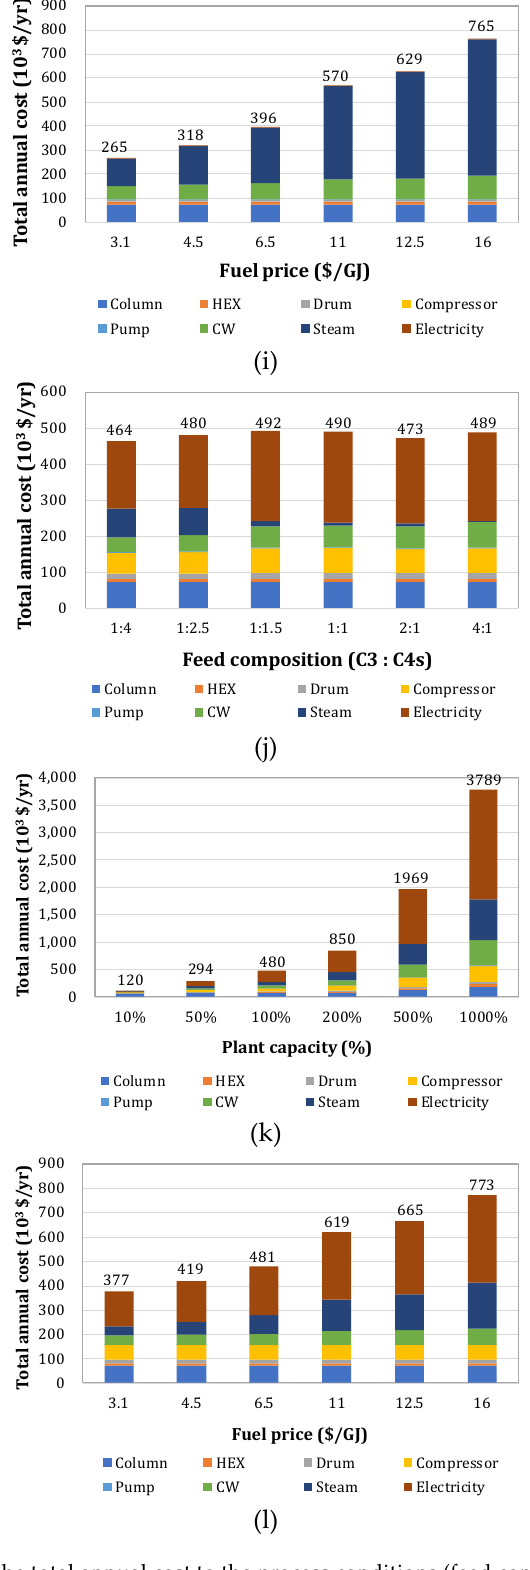
Figure 4. Sensitivity of the total annual cost to the process conditions (feed composition, plant capacity, and fuel price): ( a ), ( b ), and ( c ) Conventional C4 splitter; ( d ), ( e ), and ( f ) heat pump-assisted C4 splitter; ( g ), ( h ), and ( i ) conventional de-propanizer; and ( j ), ( k ), and ( l ) heat pump-assisted de-propanizer.